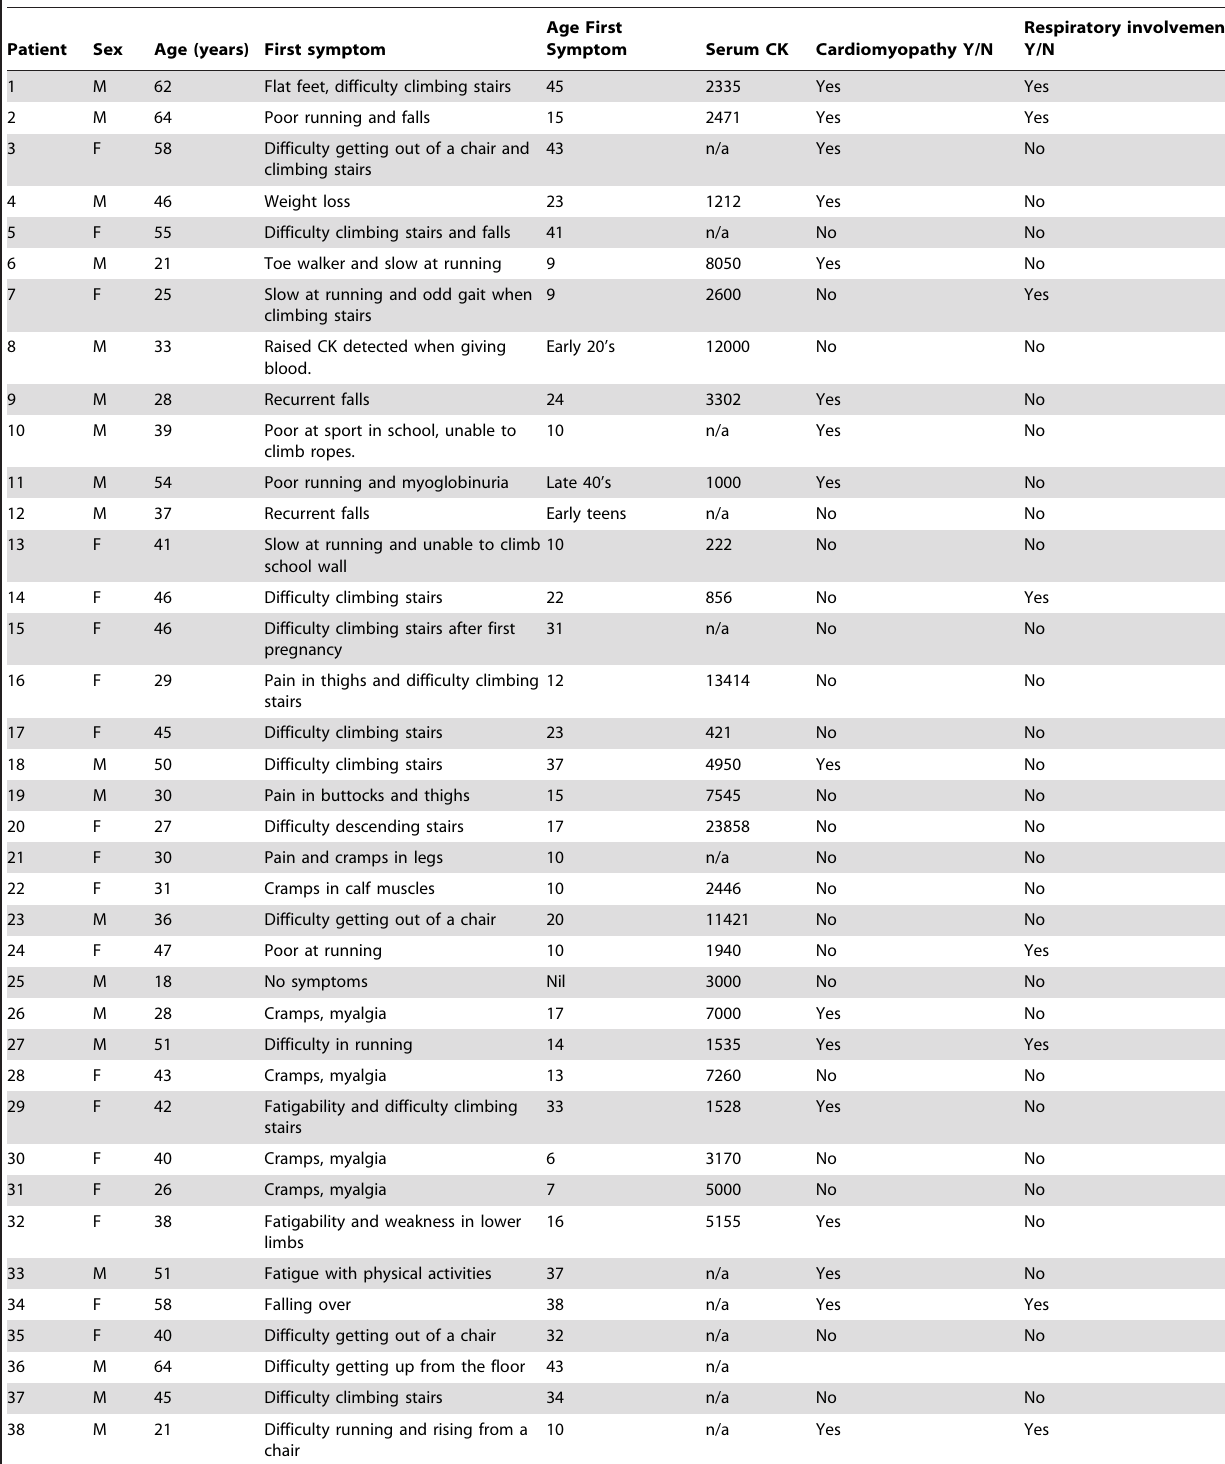
Table 1. Summary table of the clinical characteristics of the LGMD2I cohort (n=38).